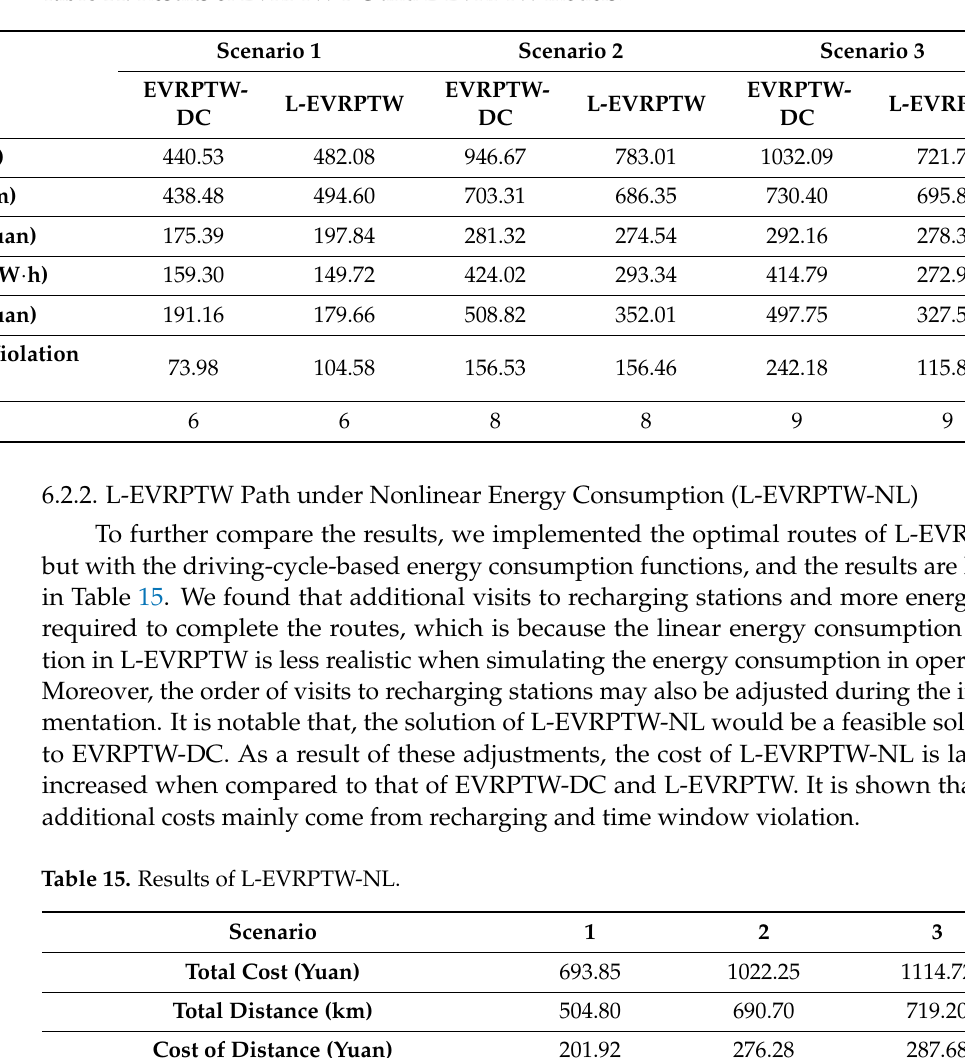
Table 14. Results of EVRPTW-DC and L-EVRPTW models.